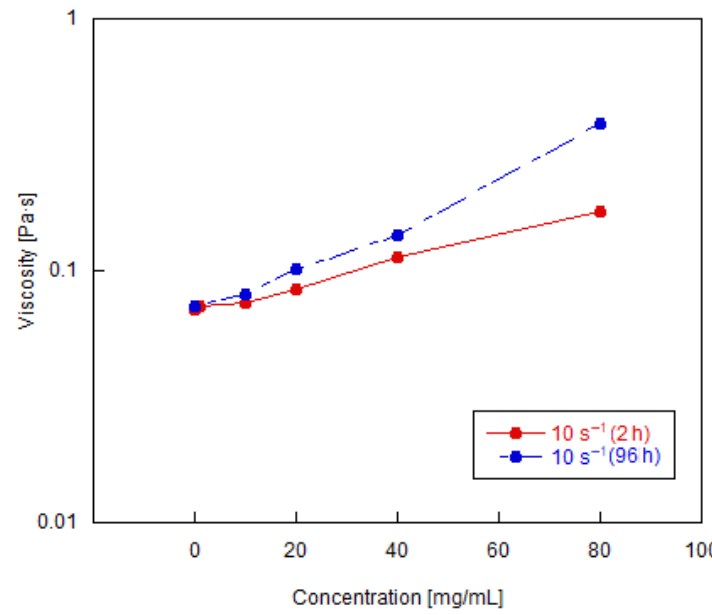
Figure 12. Shear viscosity of suspensions of GO as a function of different GO concentrations at shear rate 10 s − 1 rate 10 s − 1 .